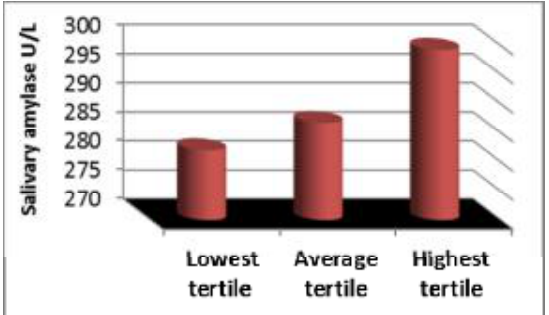
Figure 4: Caries experience (DMFT) in relation to salivary α - amylase level